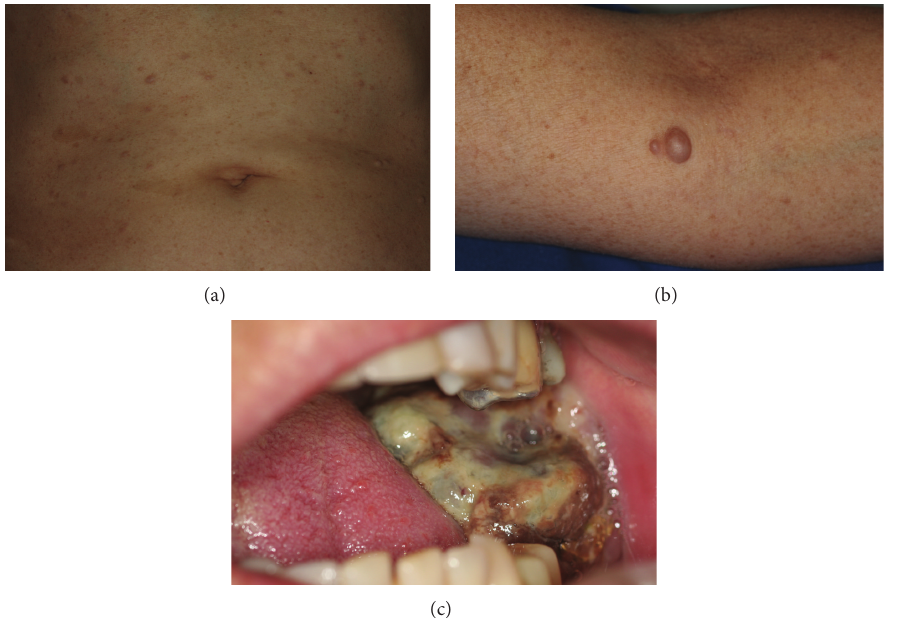
Figure 1: (a) Abdominal surface presenting caf´e au lait macules and multiple cutaneous neurofibromas. (b) Upper member with cutaneous neurofibromas. (c) Intraoral view showing an extensive tumor with necrotic surface located on the left retromolar